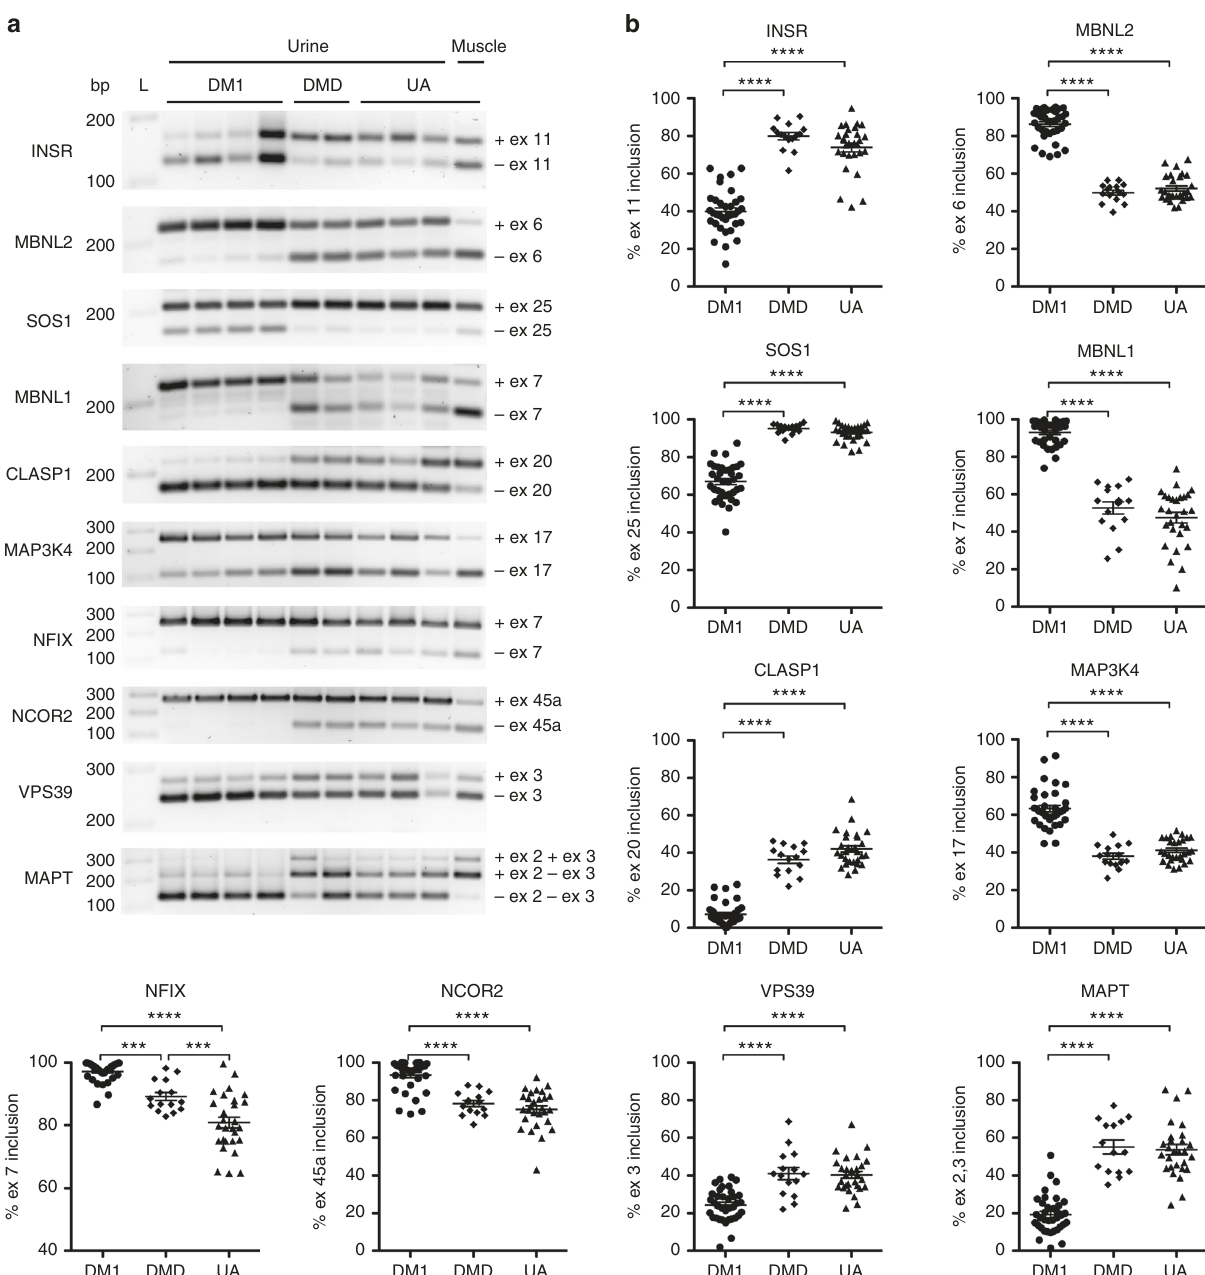
Fig. 2 Alternative splicing of extracellular mRNA from human urine. We isolated urine exRNA from 36 DM1, 15 DMD/BMD controls (DMD), and 28 unaffected (UA) subjects, and examined alternative splicing by RT-PCR and gel electrophoresis 4 . Commercially available total RNA from skeletal muscle tissue served as a control. a Representative gel images showing alterative splicing of INSR exon 11, MBNL2 exon 6, SOS1 exon 25, MBNL1 exon 7, CLASP1 exon 20, MAP3K4 exon 17, NFIX exon 7, NCOR2 exon 45a, VPS39 exon 3, and MAPT exons 2 and 3. PCR cycle number was 36 ( INSR , MBNL2 , SOS1 , CLASP1 , MAP3K4 , NFIX , NCOR2 , and VPS39 ) or 37 ( MBNL1 and MAPT ). Control muscle cDNA was diluted 1:100 and ampli fi ed in the same PCR reaction as urine samples. “ L ” = DNA ladder. “ bp ” = base pairs. b Individual data points represent quanti fi cation of splicing in urine exRNA samples of all individuals examined. Error bars indicate mean ± s.e.m. **** P < 0.0001; *** = mean difference 8.0, 95% CI of difference 3.2 – 12.7 ( NFIX , DM1 vs. DMD/BMD) and